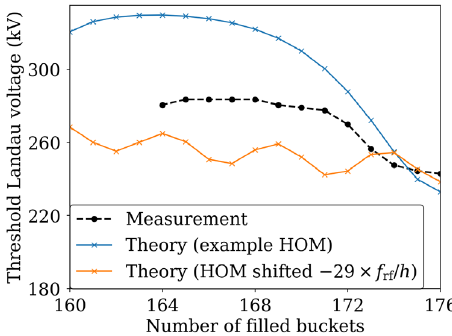
FIG. 5. Beam spectra as measured by the phase detection of the bunch-by-bunch feedback system along with the spectrum of coupled-bunch mode 138 and the frequency response of the FIR filter used in the feedback loop.